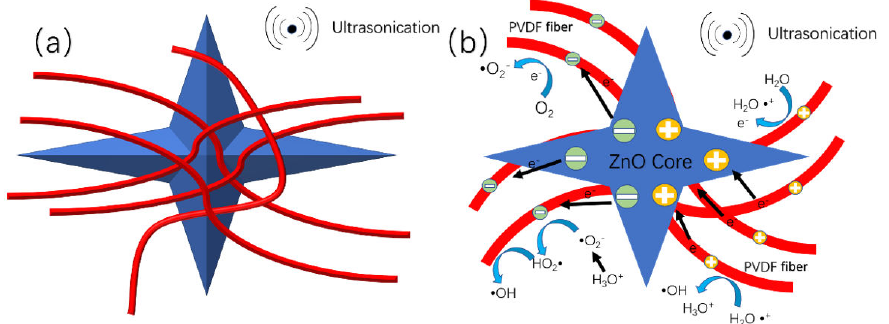
Figure 7. Mechanism of the contact-piezoelectric bi-catalysis of MO degradation under ultrasonica- tion. ( a ) Schematic diagram of the structure of ZnO@PVDF composite membrane (red = PVDF fiber; blue = tetrapodal ZnO). ( b ) Schematic diagram of proposed mechanism of the contact-piezoelectric